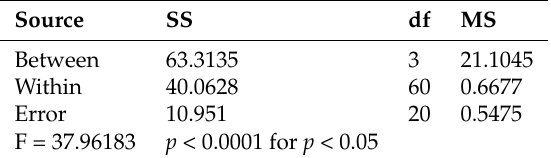
Table 9. One-way repeated ANOVA for P-score between native and non-native English